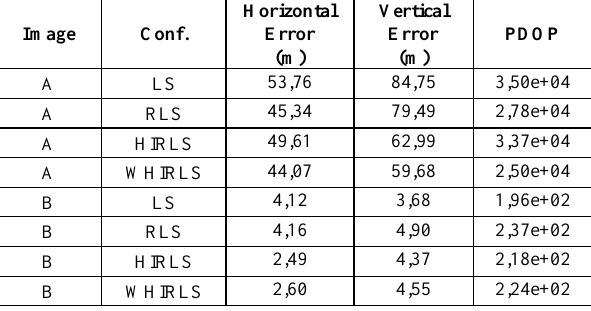
Table 4. Camera Position Error with blunder on marker